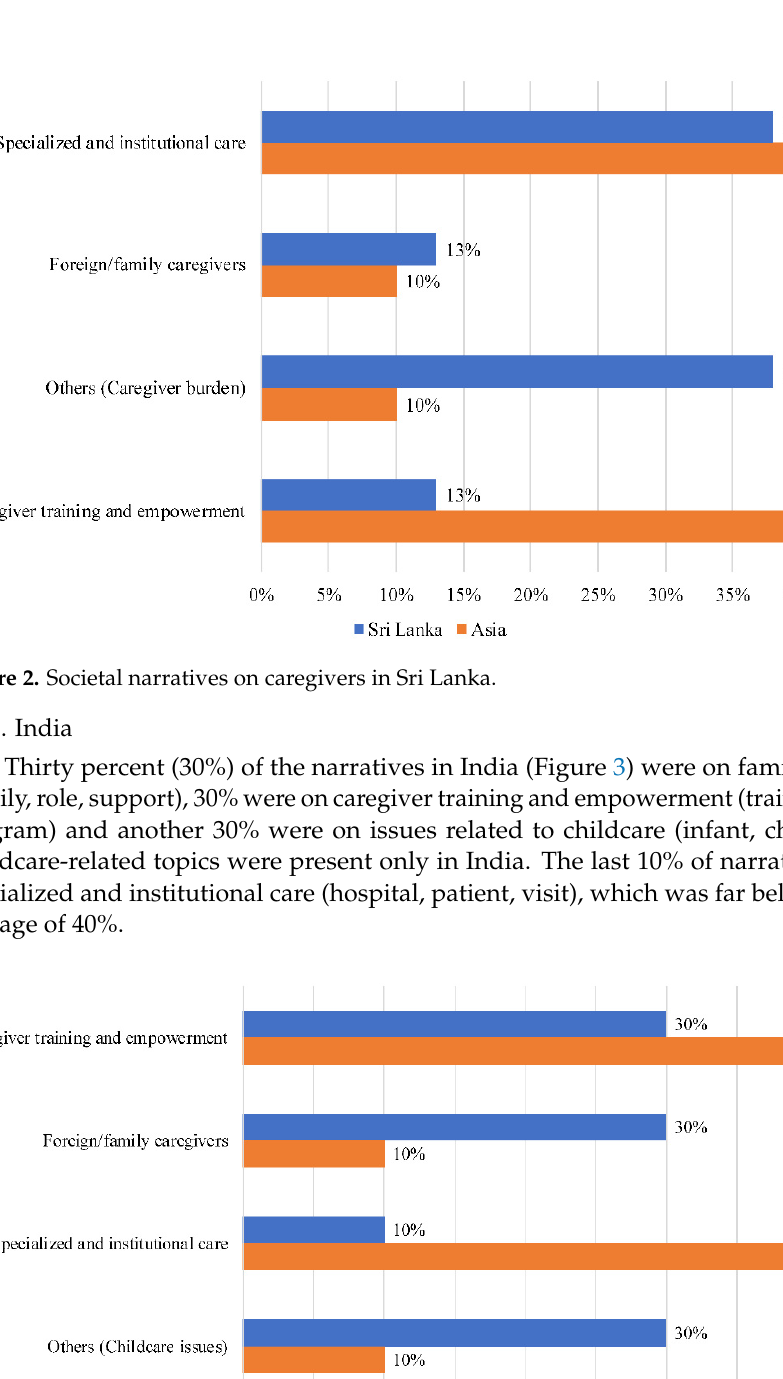
Figure 4. Societal narratives on caregivers in Hong Kong. 3.2.5. Philippines Only in the Philippines (Figure 5) did the topic of nursing training and overseas em- ployment surface. Seventy-eight percent (78%) of narratives centred around this topic (Fil- ipino, abroad, work). In total, 11% of narratives were regarding specialized as well as in- stitutional care (hospital, professional, worker), while the remaining 11% were on family caregivers (parent, partner, spouse). Unlike in the rest of Asia, there was no discussion on caregiver training and empowerment in the Philippines.